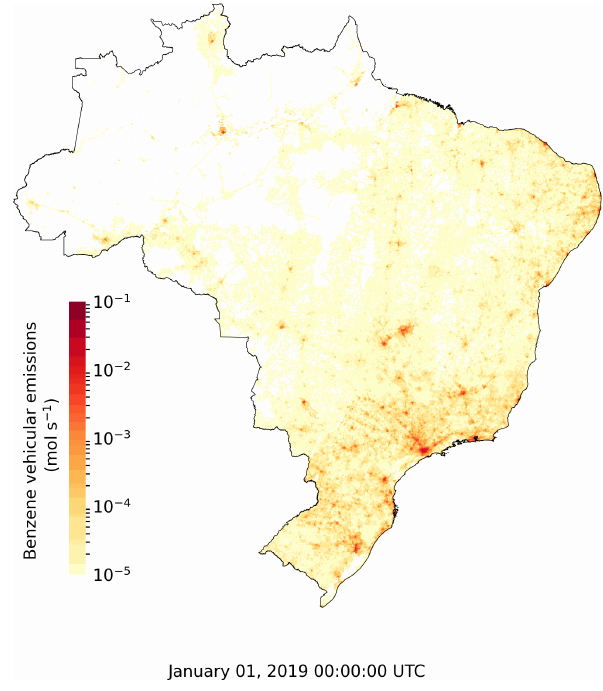
Figure 7. Vehicular emissions of Benzene in Brazil on 1 Jan- uary 2019 using the BRAVES